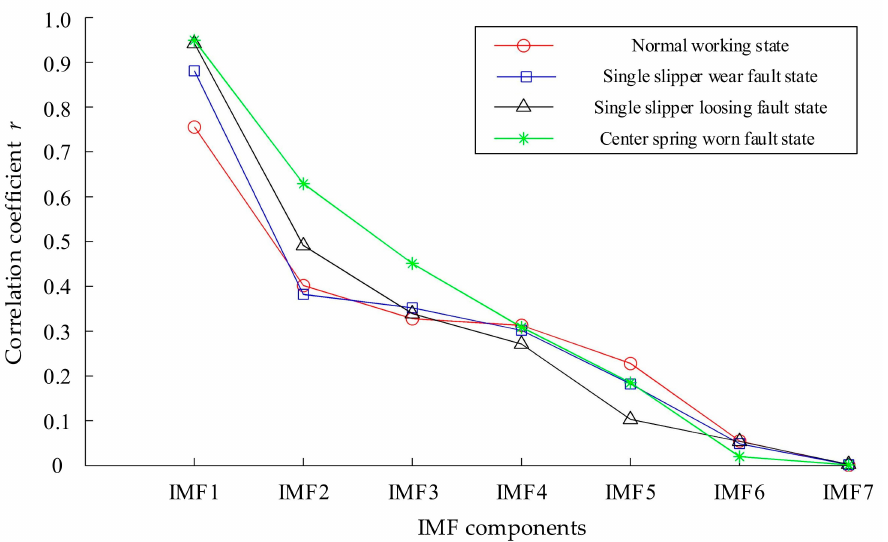
Figure 12. Correlation coefficients between intrinsic mode function (IMF) components of hydraulic pump and original signal.